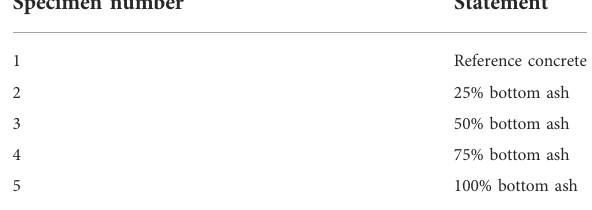
TABLE 1 CSs for different BARs.